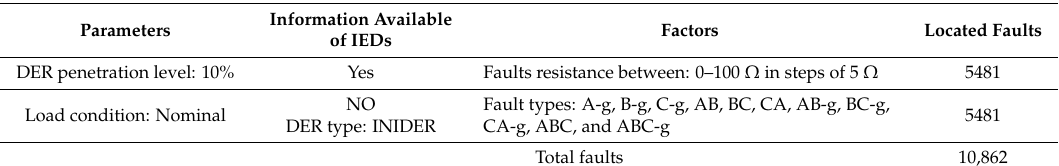
Table 1. Simulation data for scenario 1. DER: distributed energy resources; IED: intelligent electronic devices.